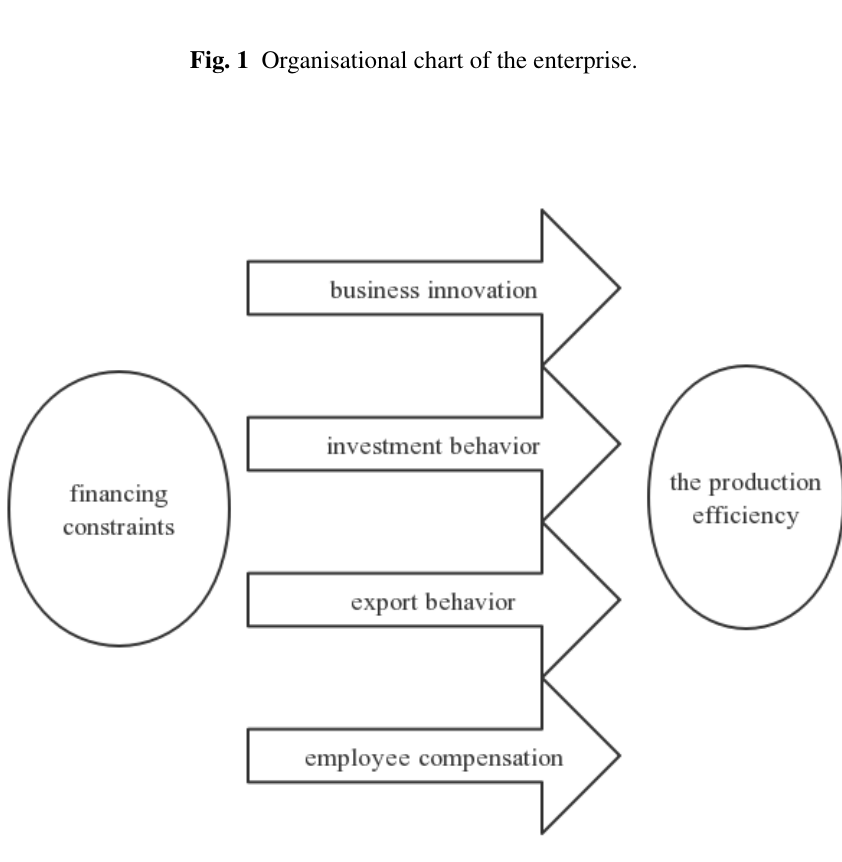
Fig. 2 Analysis of the impact of financing production on enterprise production